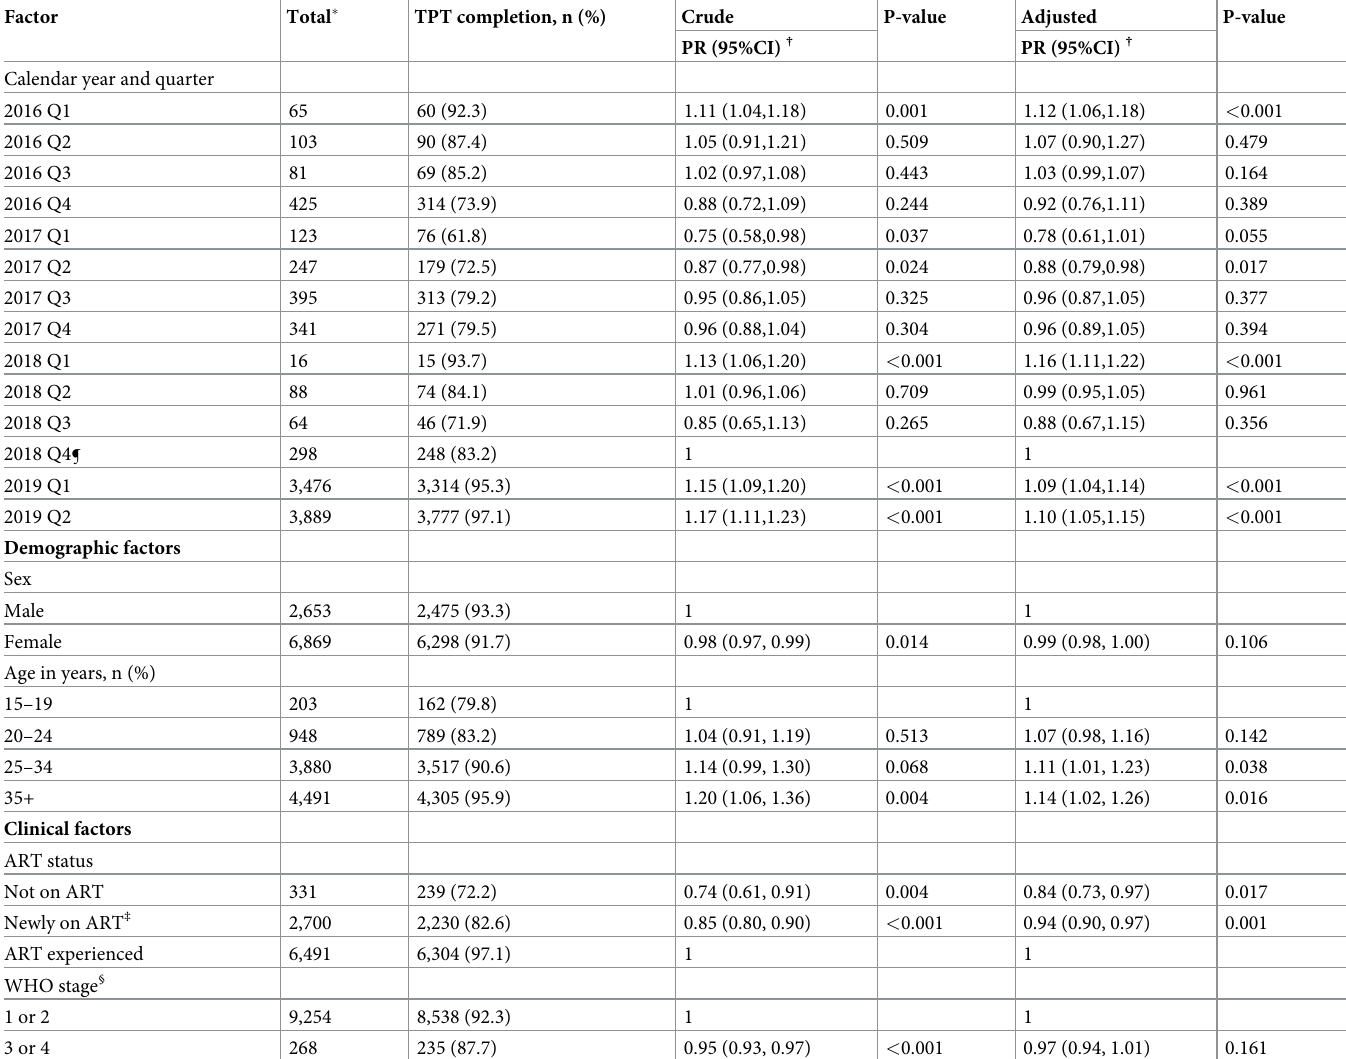
Table 3. TPT completion and associated